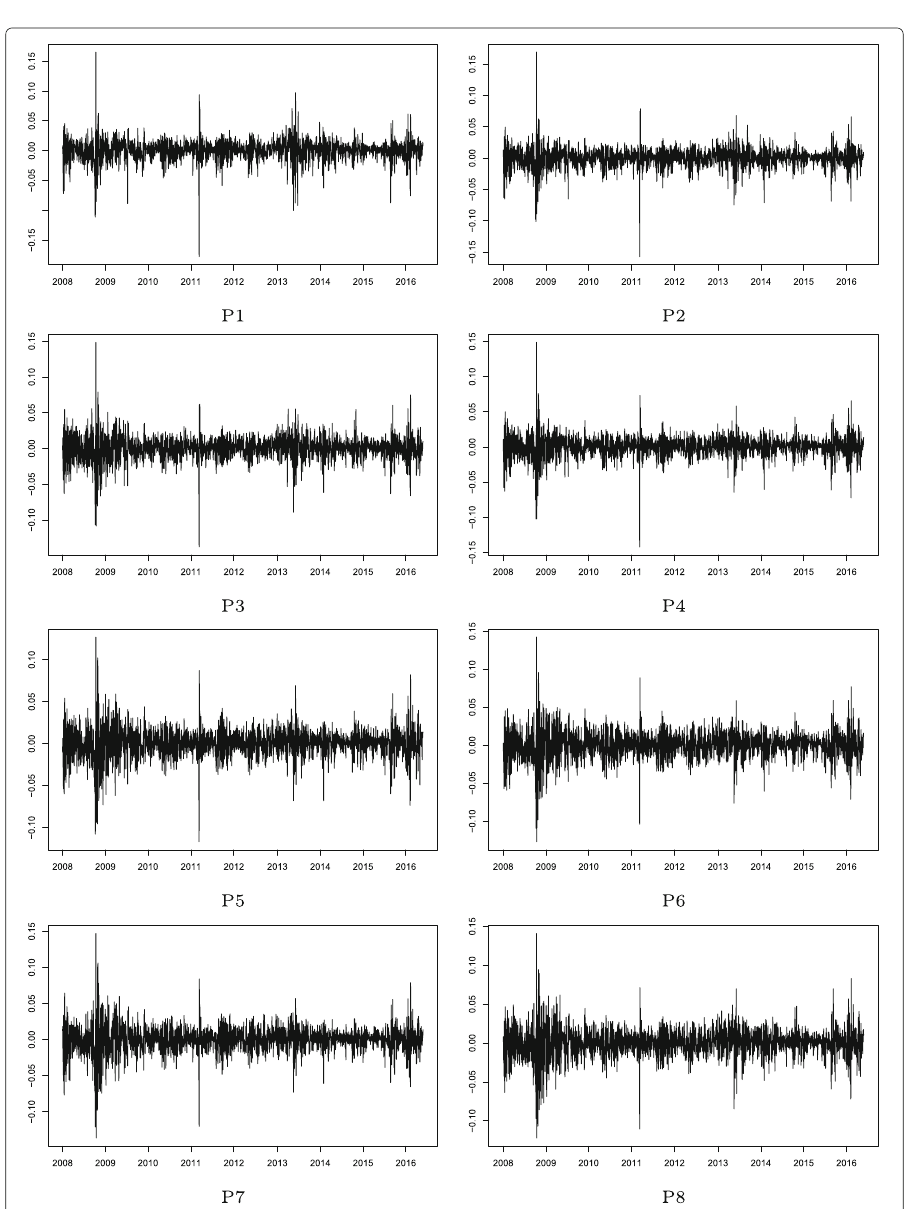
Fig. 4 Stock returns: Cyclical group sub-portfolios. Note: The stock return of a sub-portfolio is calculated as the daily log return of the stock price index of the group-based sub-portfolio shown in Fig. 2